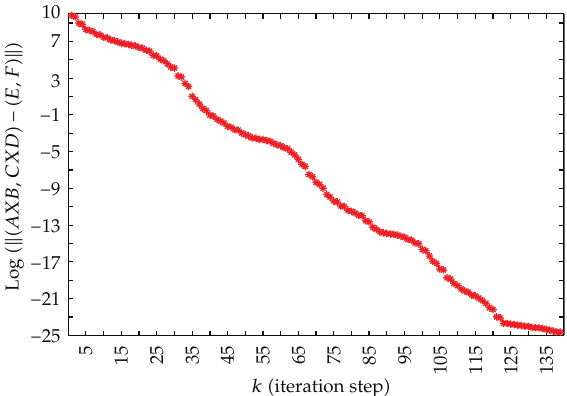
Figure 1: Convergence curve for the Frobenius norm of the residual for Example 4.1 with X 1 (cid:2) 0